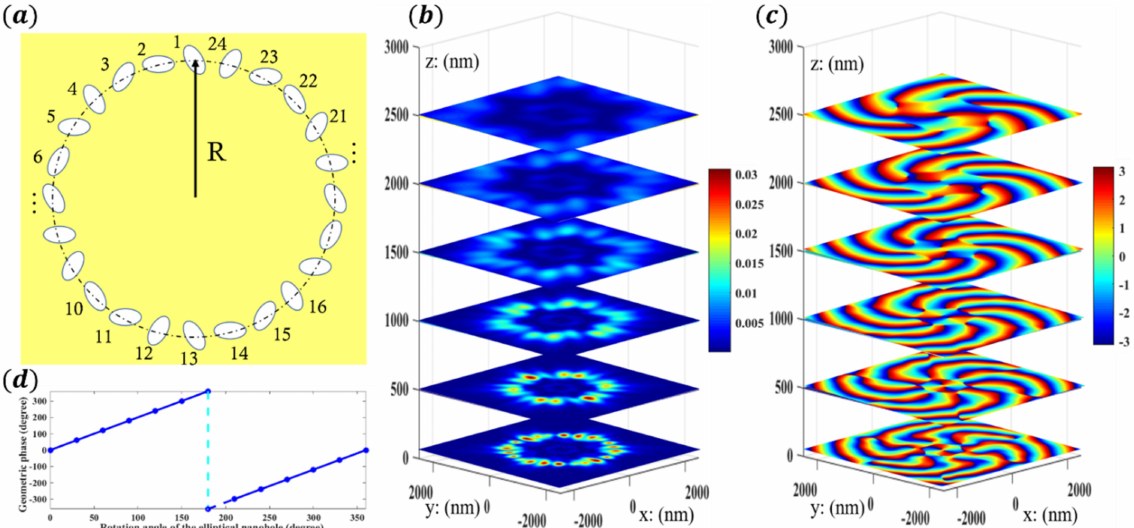
Figure 2. Design schematic of the geometric metasurface and a display of the eighth-order optical vortices’ (OVs) morphology. ( a ) The arrangement scheme of metal elliptical nanoholes inducing high topological charges. ( b , c ) The distribution of the focal ring energy and the spatial phase change on the propagation path of light scattered behind the metasurface of single-layer metal nanoholes, respectively. ( d ) The geometric phases produced by different rotation angles of elliptical